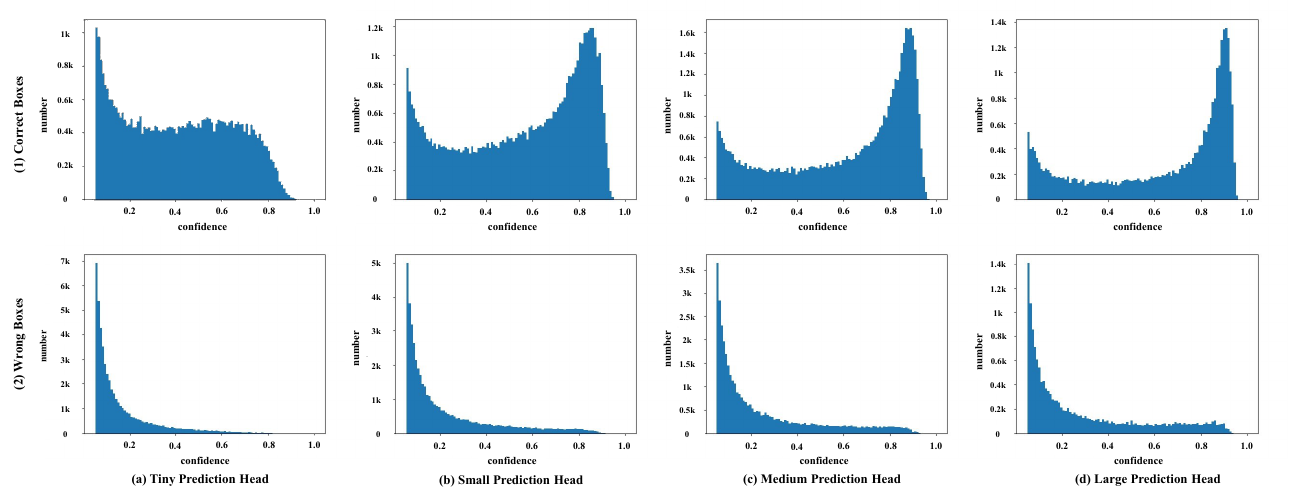
Figure 4. The distributions of confidence of each prediction bounding box generated by four predic- tion heads. The bounding boxes are split into correct boxes and wrong boxes. The first and second row are the distributions of correct and wrong boxes, respectively.